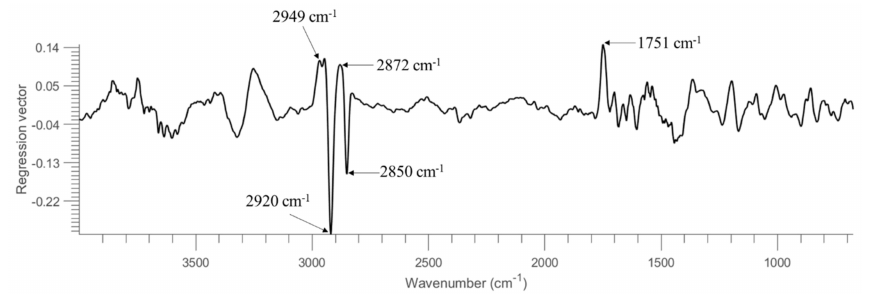
Figure 3. Regression vector of PLSDA model built from samples on STS using the entire spectral